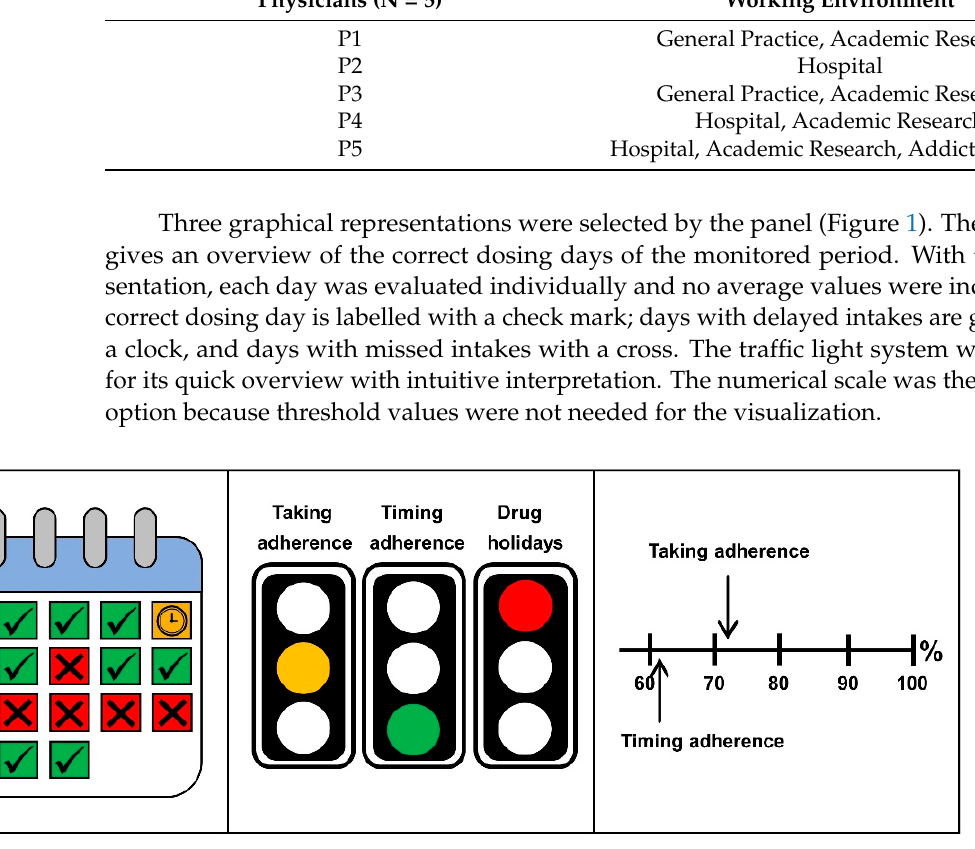
Table 1. Characteristics of the pharmacist and physician panel participants.